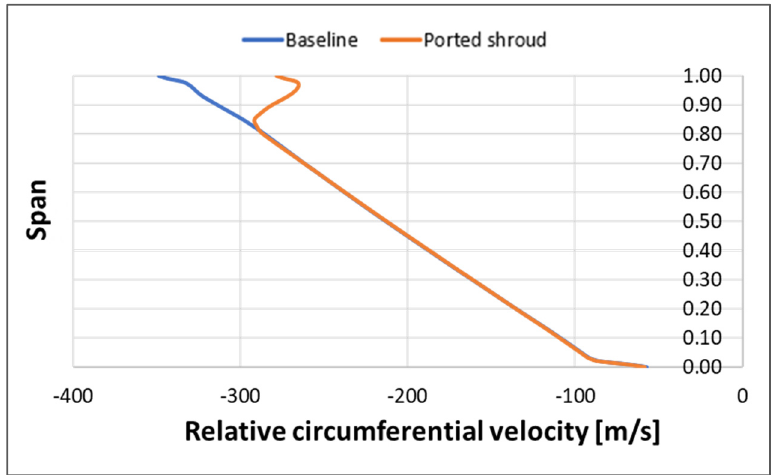
Figure 16. Comparison of the hub-to-shroud distribution of the relative circumferential velocity at the leading edge between the configurations with ported shroud and baseline, at the best efficiency condition OP1.